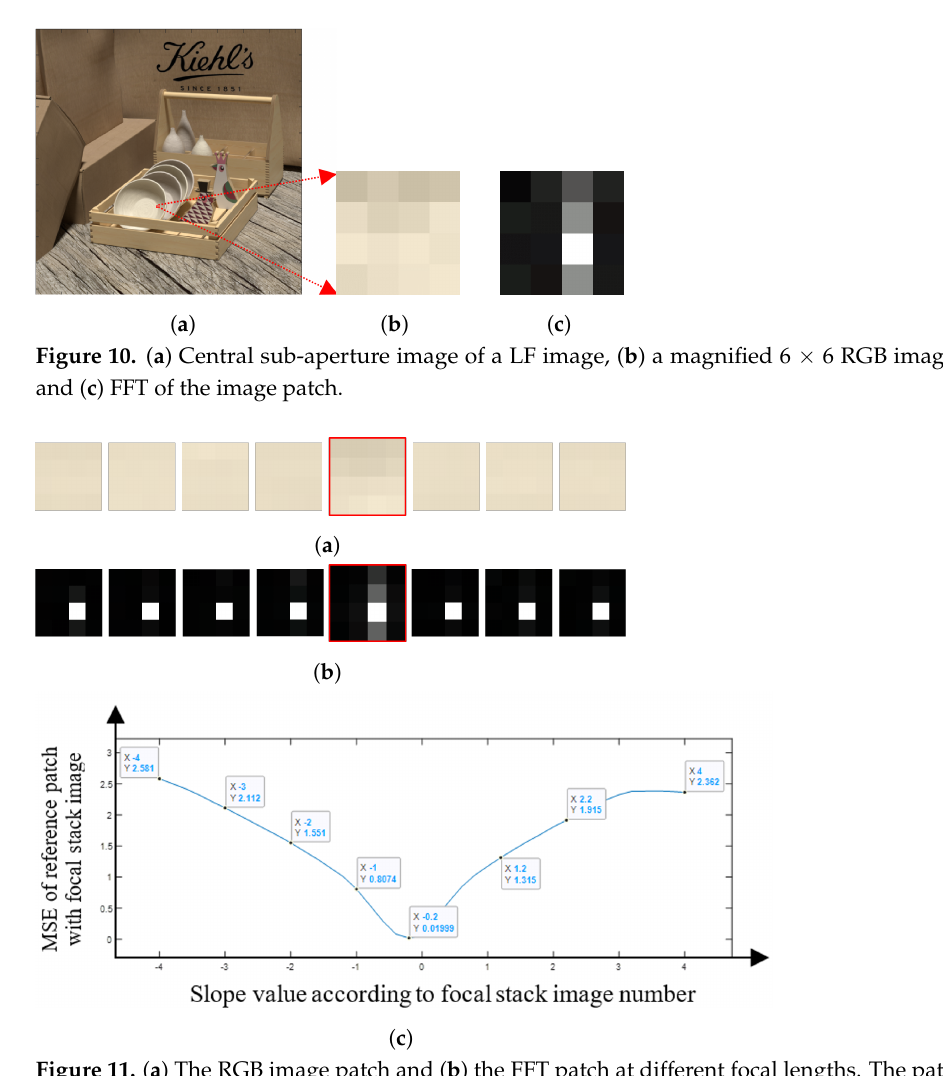
Figure 11. ( a ) The RGB image patch and ( b ) the FFT patch at different focal lengths. The patch with the red boundary is the closest match to the reference patch in Figure 10. ( c ) The graph shows the MSE values for the central image in Figure 10, with the corresponding focal stack image